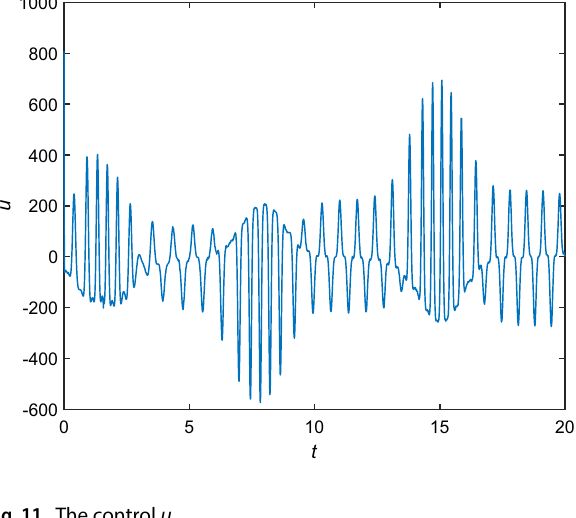
Fig. 11 The control u